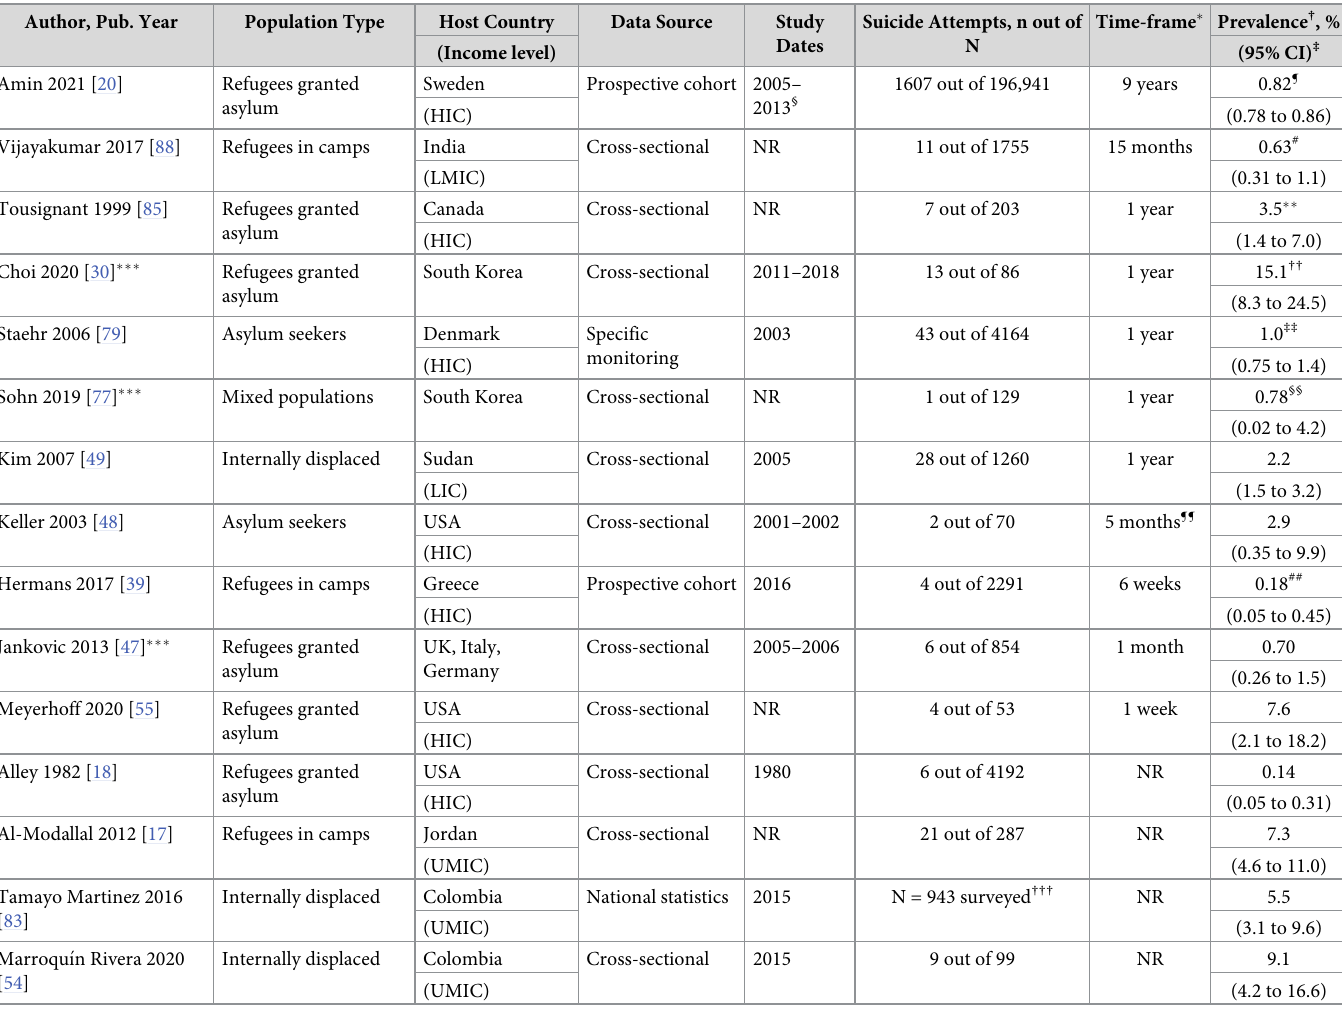
Table 3. Suicide attempt prevalence percentage in general samples, ordered by timeframe (and then by population type). Author, Pub.